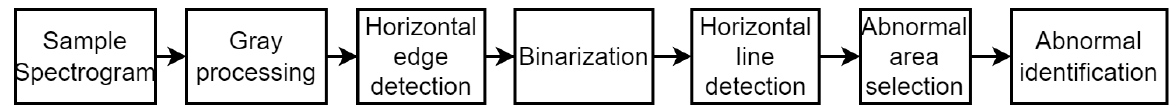
Figure 4. Automatic identification algorithm process.